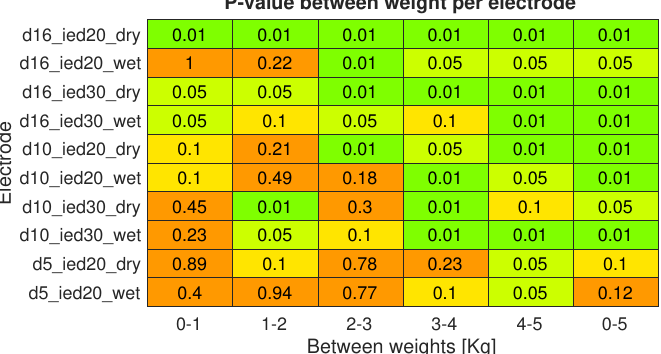
Figure 16. Probability value of all subjects between different load samples for all tested electrodes sizes and conditions (0.01, 0.05 and 0.1 indicate a p -value below the subsequent